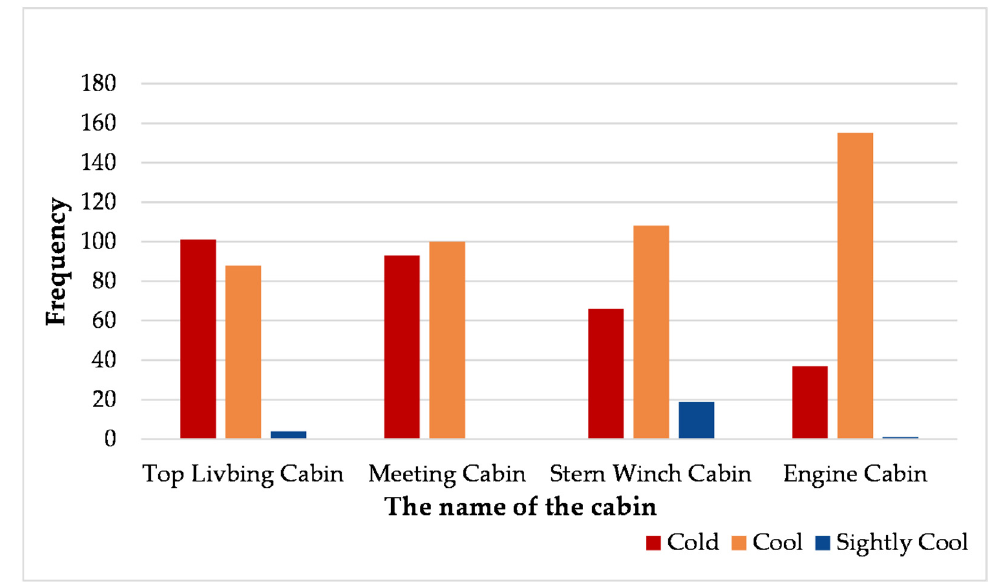
Figure 19. Thermal comfort frequency in the ship.